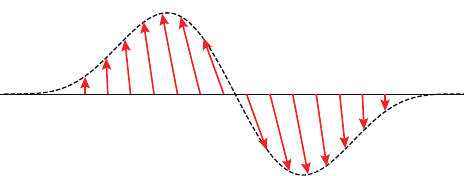
Figure 7. Domain-wall soliton corresponds to a topological kink. Pseudospin vector rotates by an angle of π out of the